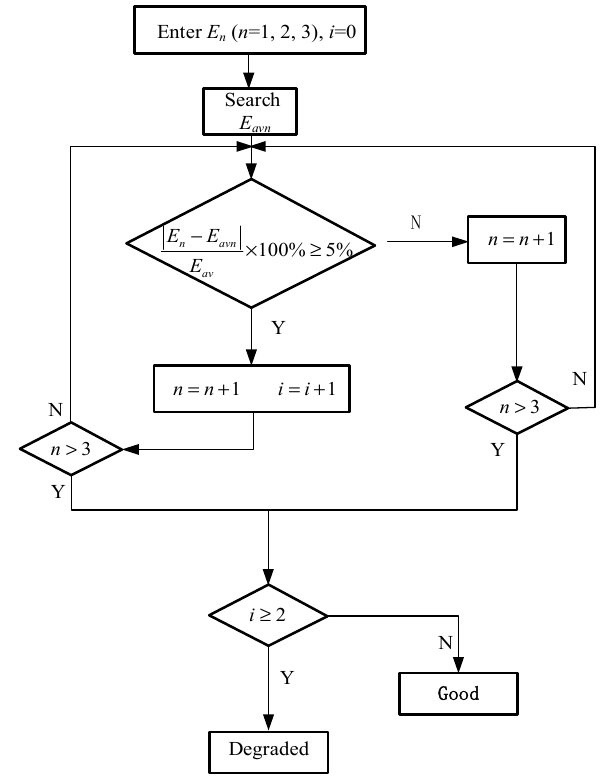
Figure 13. Test diagrams and schematic diagrams of sensitive insulators.